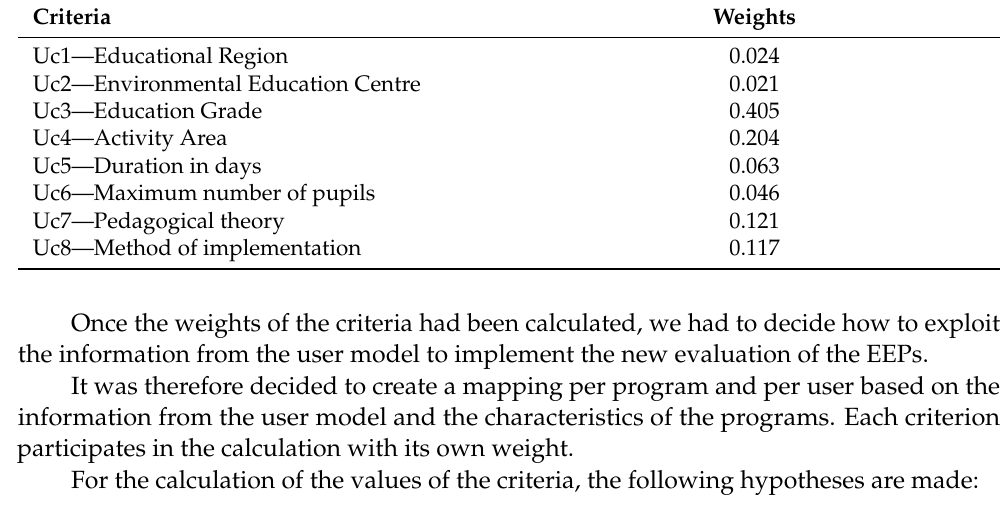
Table 4. The estimated weights of the Adaptive Evaluation.